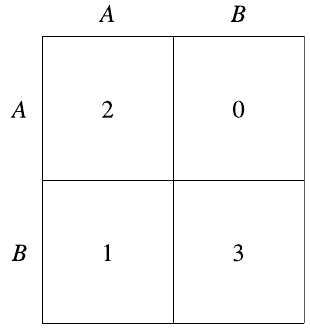
Figure 4. A game where PIID selects an efficient